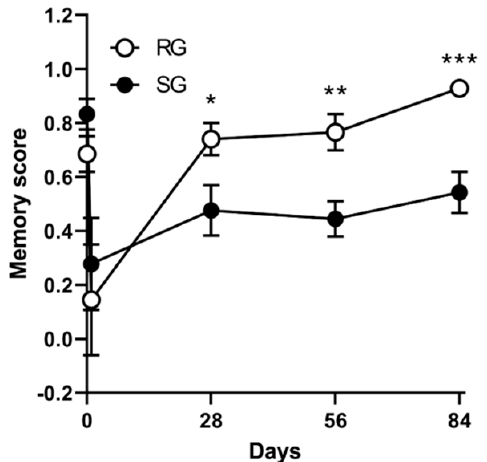
Figure 5. Improvements in memory function as determined using the radial arm maze test memory scores ( n = 12 per group; F = 3.365; p = 0.04). Vertical bars indicate standard errors. * p < 0.05, ** p < 0.01, and *** p < 0.01 vs. SG group by Mann–Whitney U test.